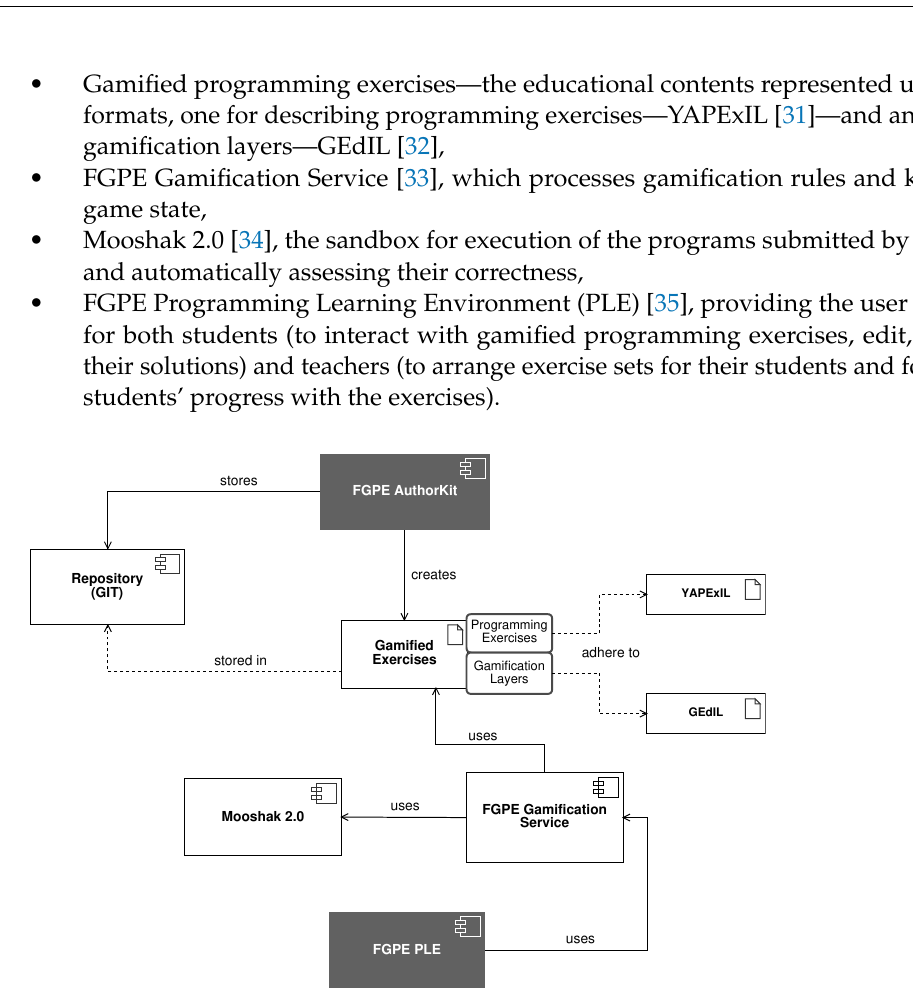
Figure 1. Architecture of the FGPE ecosystem, highlighting the FGPE AuthorKit and FGPE